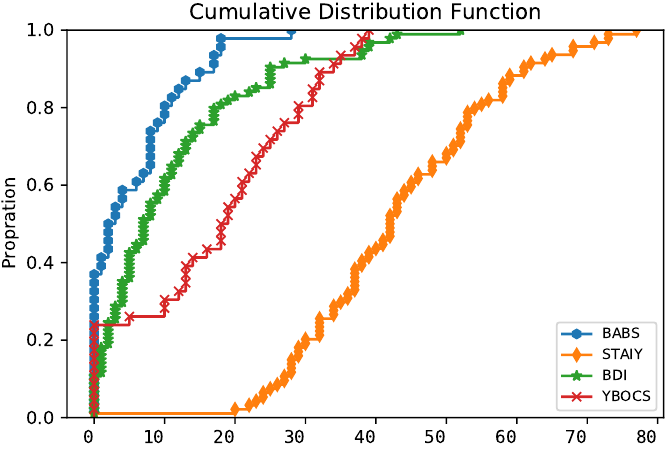
Figure 1. Cumulative distribution function of all scales at